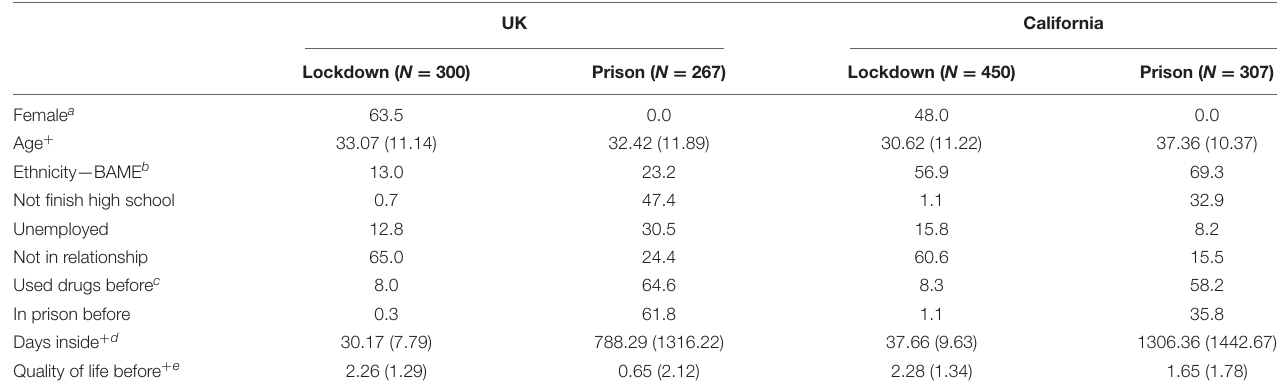
TABLE 1 | Demographic characteristics of UK and Californian lockdown and prison samples (% unless otherwise